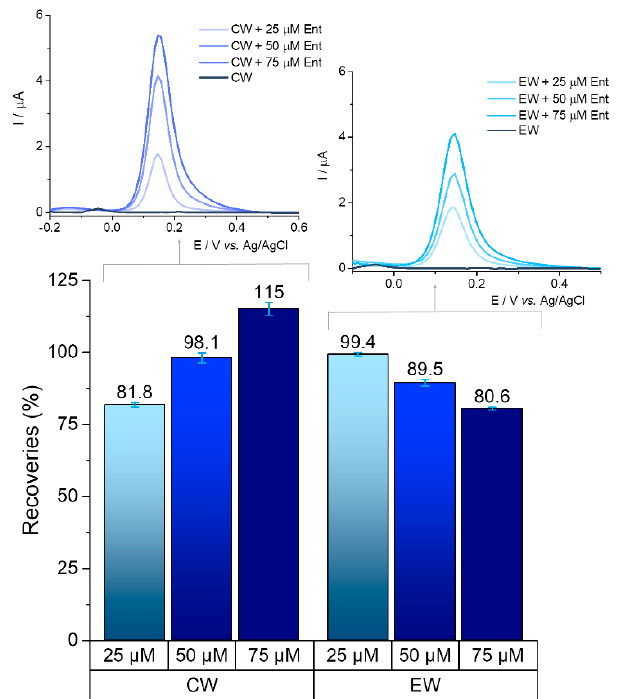
Figure 9. Recoveries obtained in wastewater samples spiked with three known concentrations of Ent; CW—primarily clarified wastewater (without sludge or other pretreatment) and EW—treated effluent; error bars represented based on standard deviation for three tests performed on each concentration; DPVs before (CW and EW) and after spiking with different concentrations of Ent (25 µ M, 50 µ M, and 75 µ M).